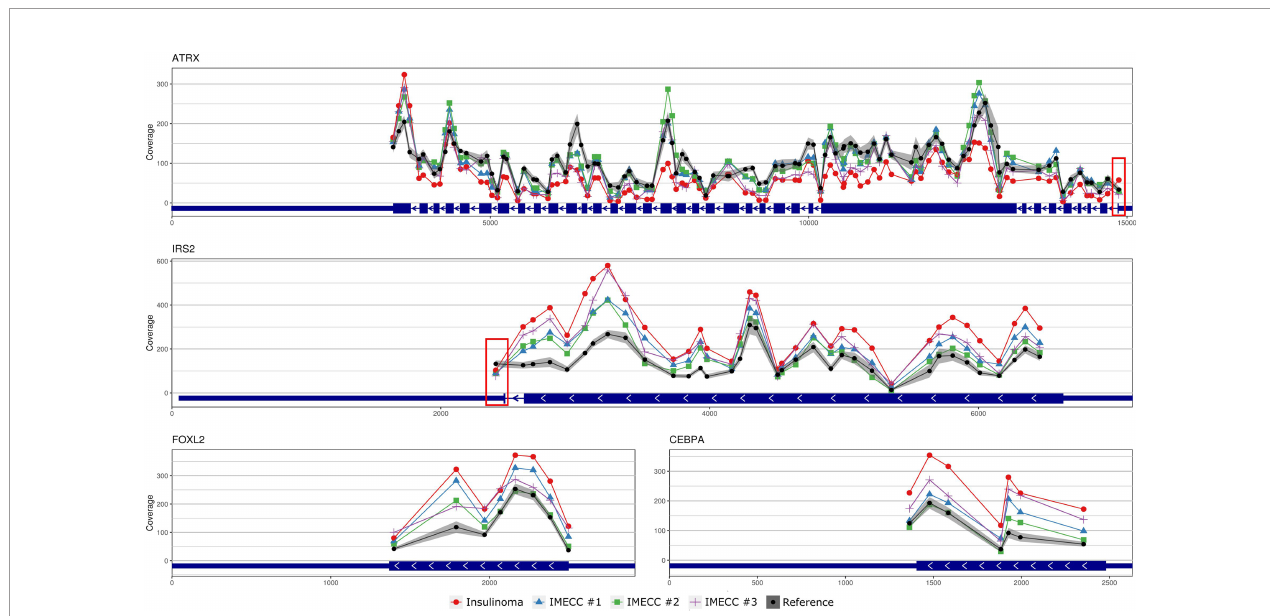
FIGURE 3 | Visualization of CNVPanelizer results on genomic coordinates (genome assembly GRCh37/hg19) of the genes ATRX , IRS2 , FOXL2 and CEBPA